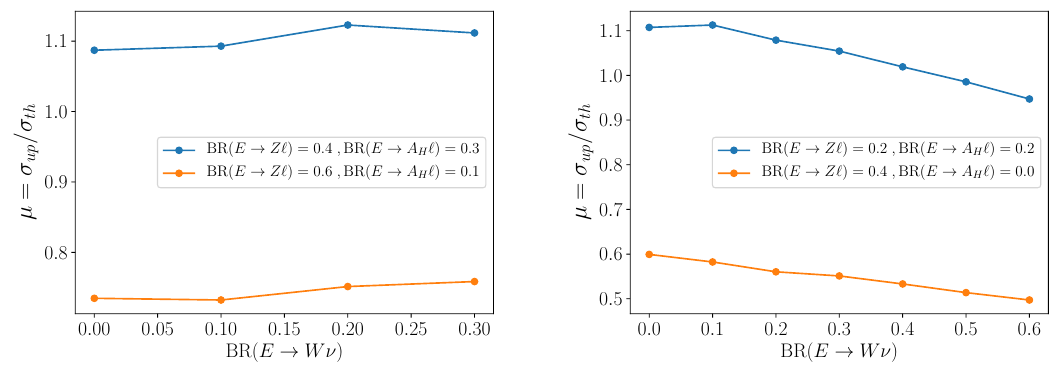
Figure 8 . Dependence of the signal strength, µ , on BR( E → Wν ) for different values of the remain- ing parameters. The masses are taken to be M E = 500 GeV and M A and M A = 98 GeV ) for the left (right) panels. Values of µ smaller than 1 are considered H